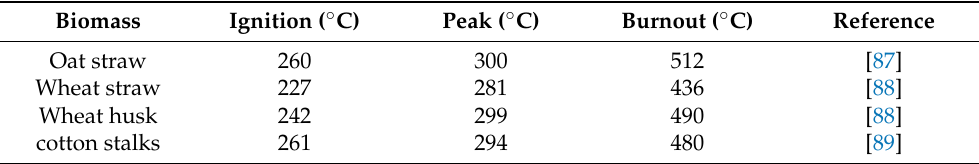
Table 7. The ignition, peak and burnout temperature of biomass.